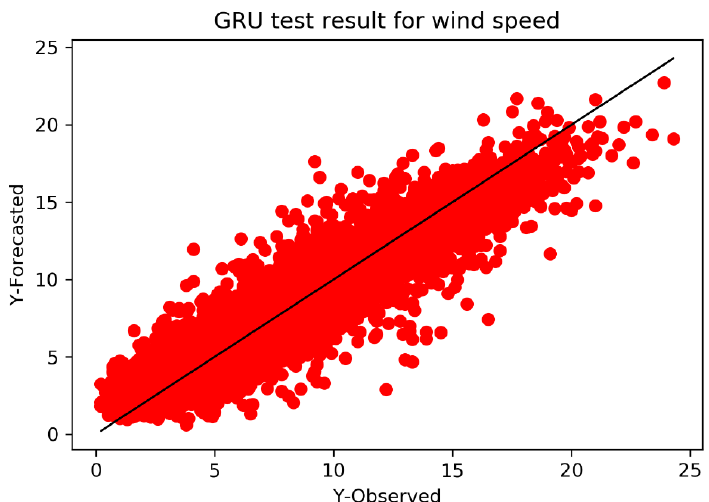
Figure 20. GRU wave height prediction.